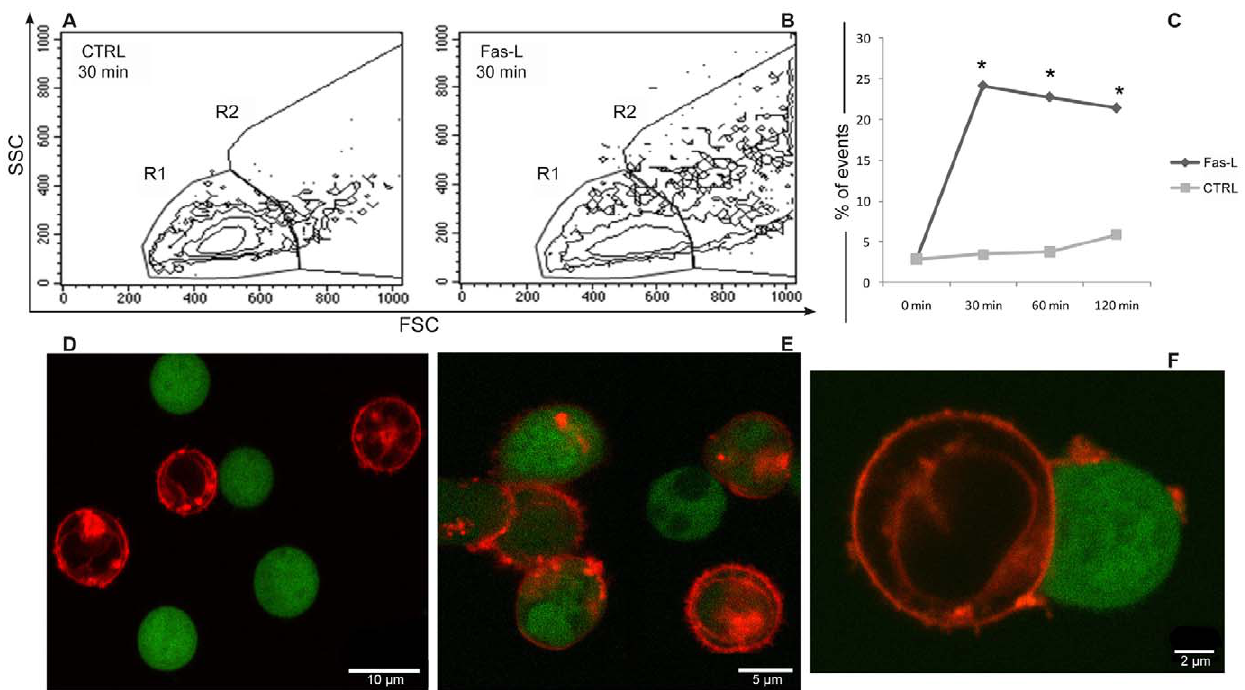
Figure 1. FasL promotes cell conjugates formation in CD4 + T lymphocytes. Contour plots show CD4 + T cells untreated (A) and treated with FasL (B) for 30 min. The treatment increases the percentage of cell conjugates identified by gate R2 drawn on physical parameters of scattering (FSC/ SSC). Statistical analysis of CD4 + T cells shows the percentage of cell conjugates at different times with (Fas-L) or without (CTRL) FasL treatment (C). The histogram highlights that FasL administration led a sharp increase of cell conjugates within 30 min, slightly decreasing later. * indicates statistical significance: p , 0.05 (n=6 experiments). The formation of cell conjugates after FasL treatment is also documented by confocal microscopy (D–F). CD4 + T cells were labelled with CFSE (green) and DiI (red). In control condition (D), the cells appear isolated with distinct fluorescences, whereas in the FasL samples (E,F) the cells are tightly linked with mixed fluorescences. These observations attest an intercellular exchange of DiI + and/or CFSE +